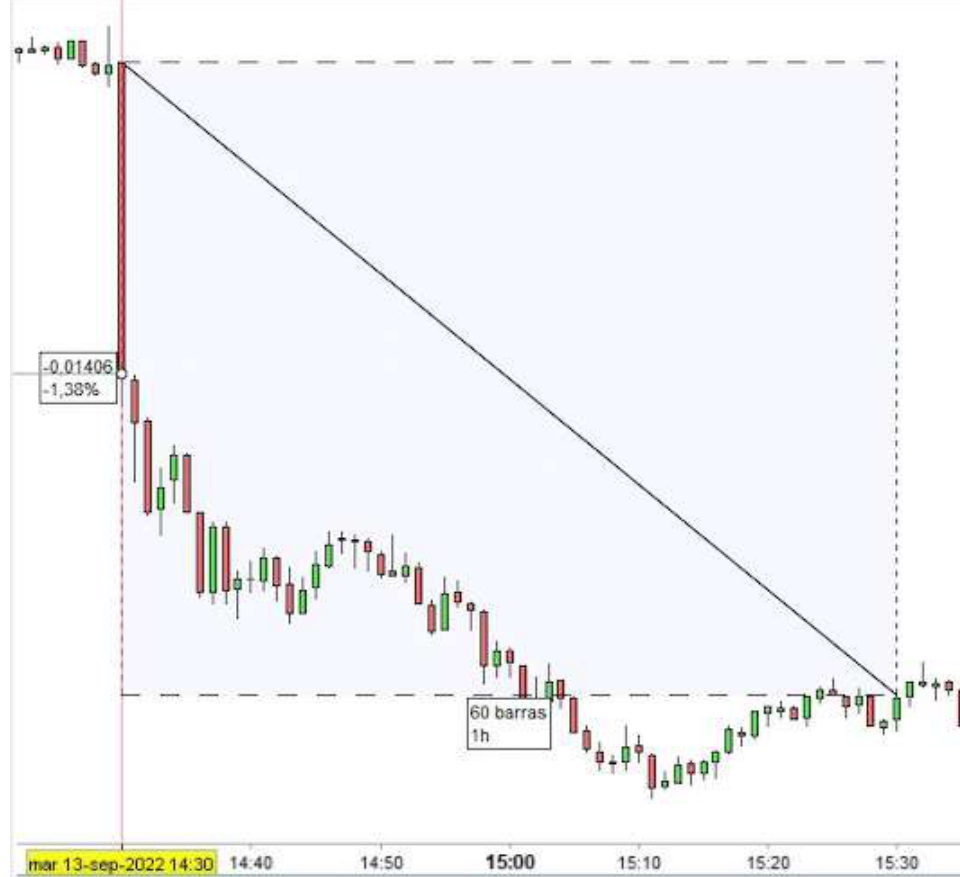
Figure 6. The data shown are the candlesticks corresponding to the EURUSD price from minute to minute. The time period selected corresponds to the publication of the macroeconomic news under consideration. In this case, the U.S. Consumer Price Index was published at 14:30 h in September 2022. Source: ProRealTime